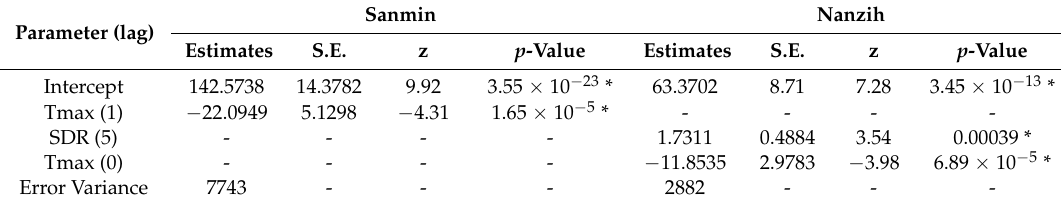
Parameter estimates for the best time series explaining abundance changes in Culex quinquefasciatus sampled with BG-sentinel traps at Sanmin (dengue transmission hotsop) and Nanzih (dengue transmission coldspot), Kaohsiung City, Taiwan. In parameters Intercept is the mean value of the time series and SD = Standard deviation, T = temperature, max = maximum, R = Rainfall. Lags are in